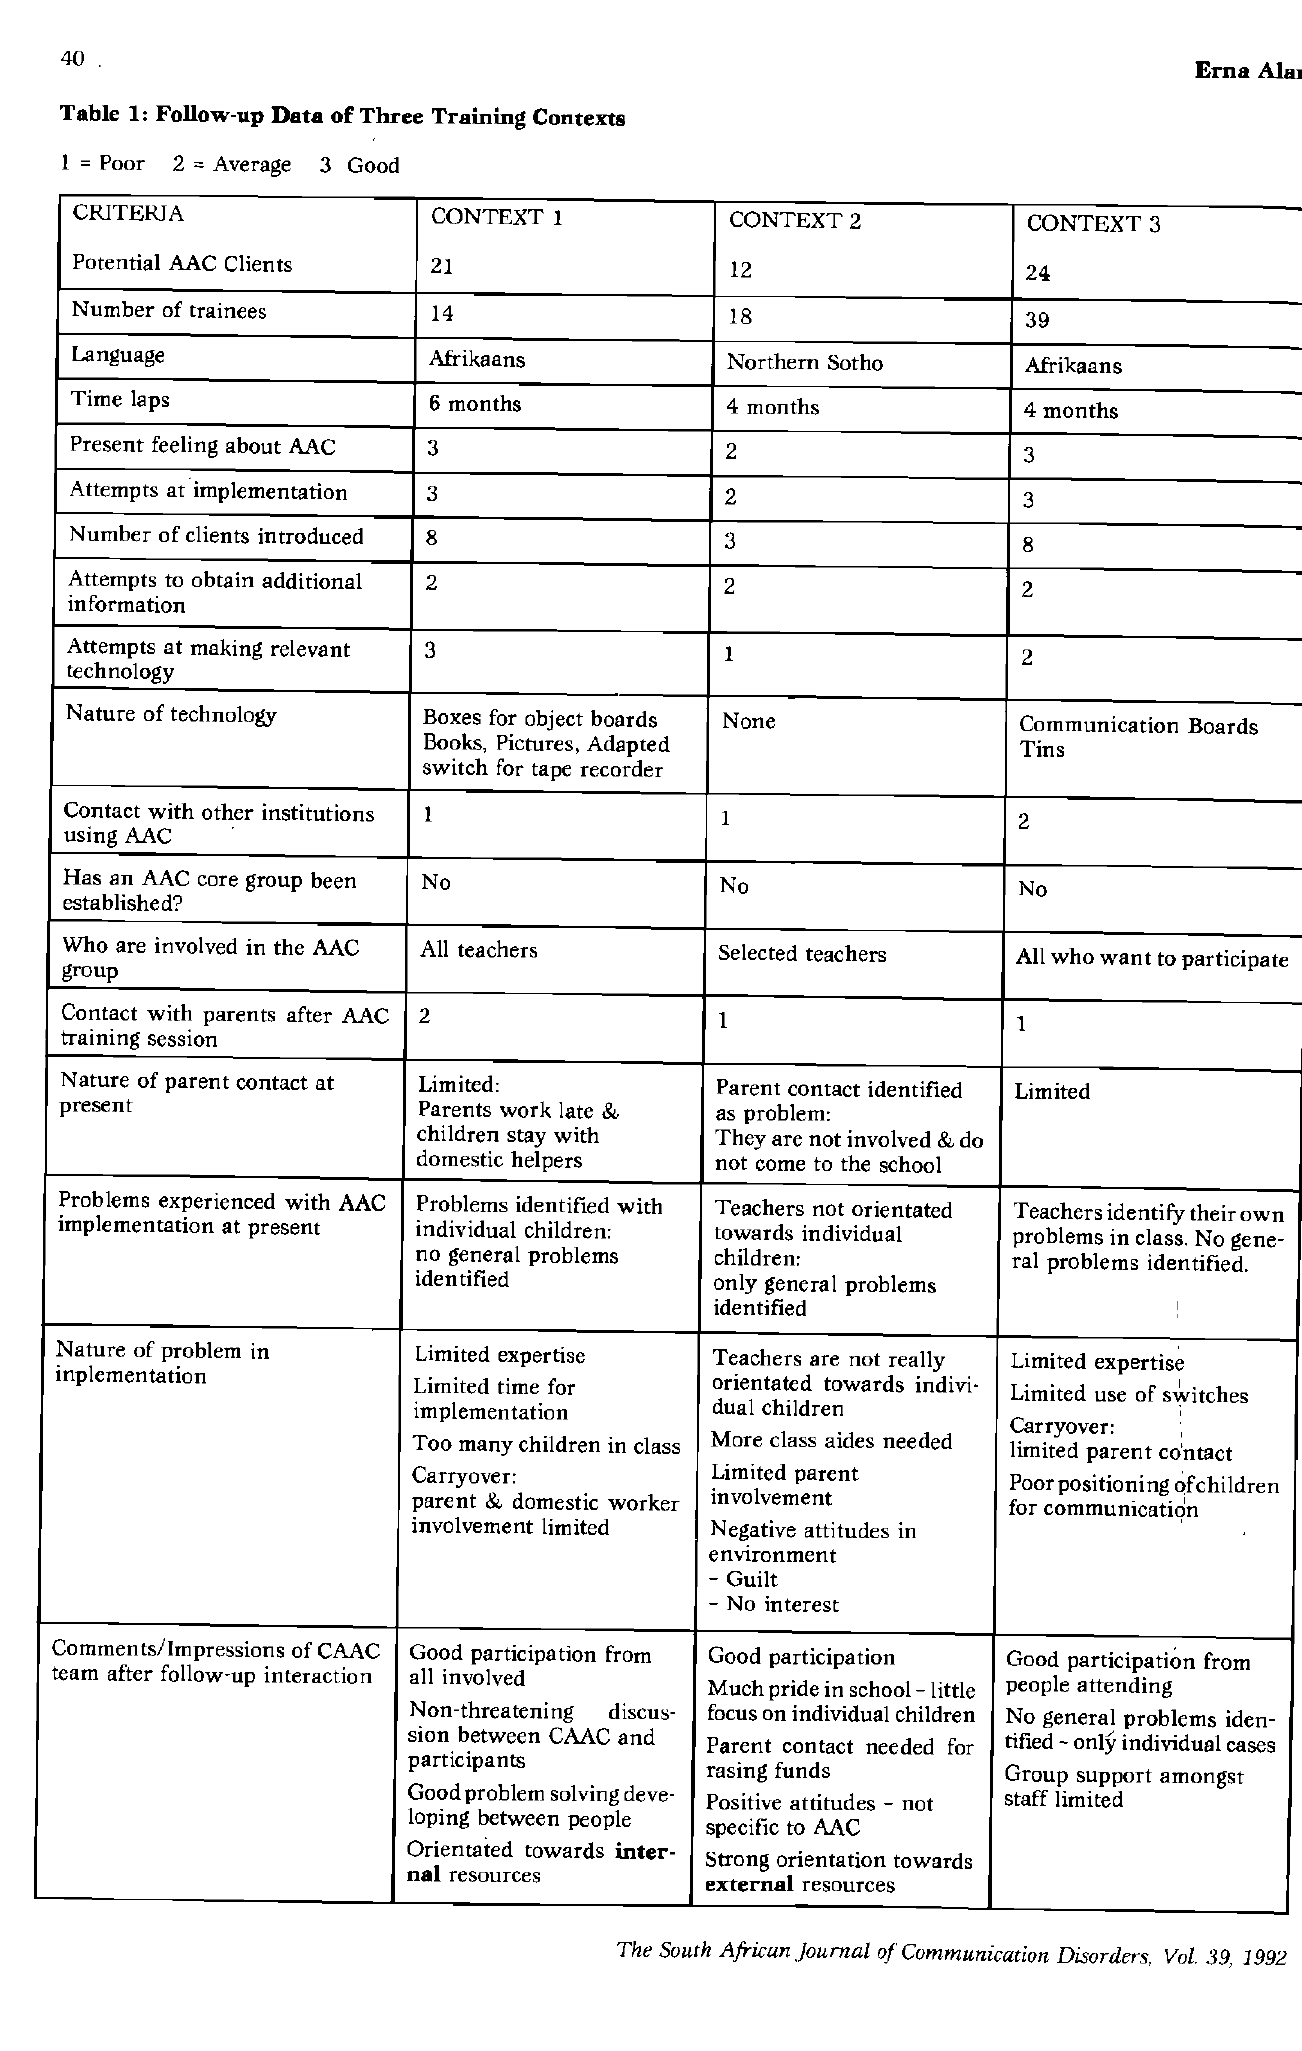
Table 1: Follow-up Data of Three Training Contexts 1 =